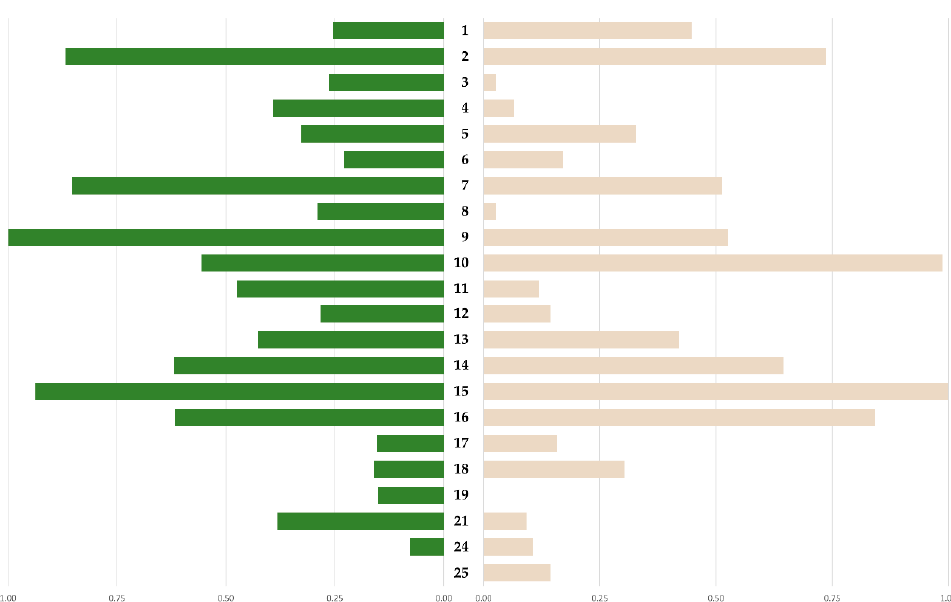
Figure 8. Comparison between citizen’s perception and actual amount of public green spaces in zones of Guatemala City. In the center the zones of Guatemala City. To the left the bars show the proportion of public green spaces area from each zone total area. To the right, bars show the proportion of mentions of each zone, which the citizens perceived with more amount of green spaces. Data was standardized using min-max normalization.